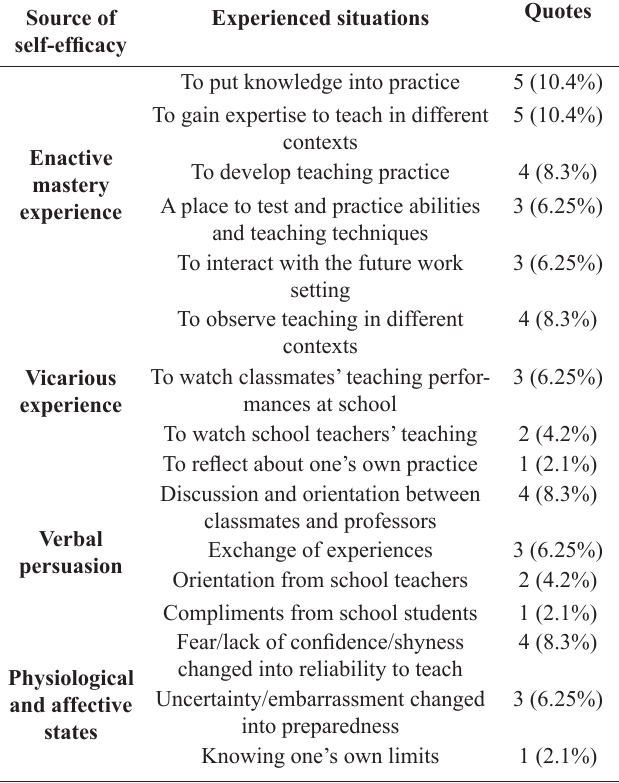
Table 1. Situations experienced during the practicum period, under- stood by student teachers as promoters of self-efficacy